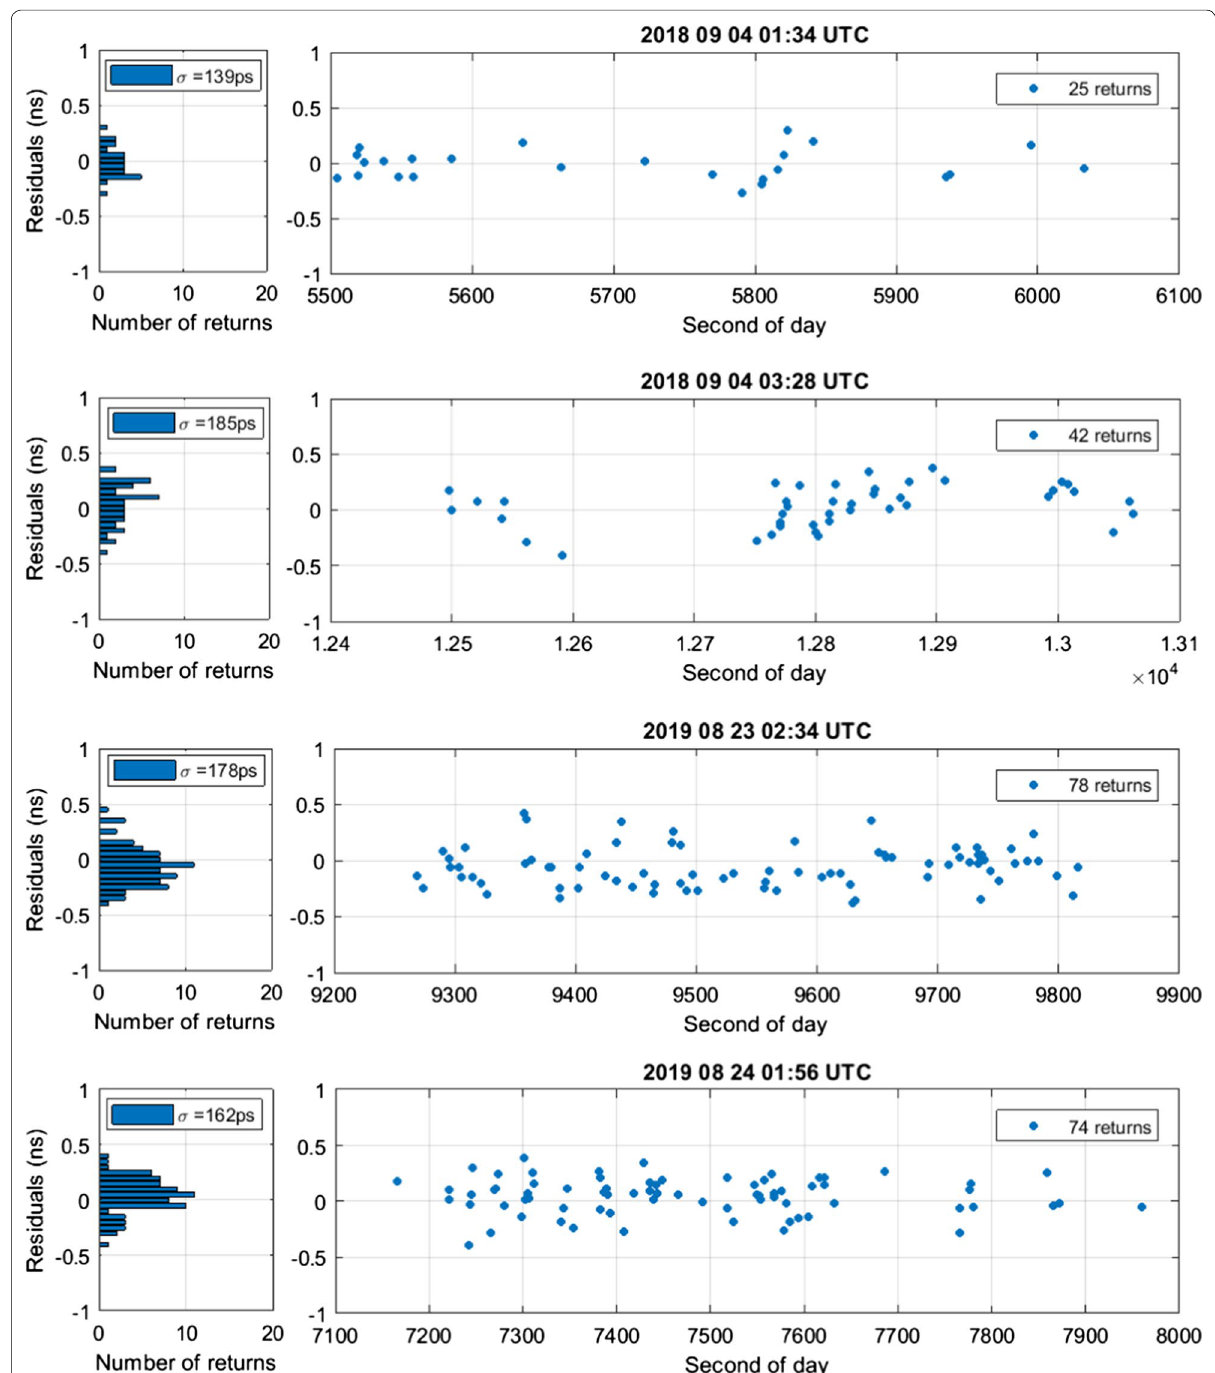
Fig. 9 Time series of the detrended residuals for the four successful passes. The residuals and their RMS are computed from the time of flight difference with the reconstructed LRO trajectory prediction made by the Paris Observatory Lunar Analysis Center (POLAC) and after a polynomial detrending (degree 3) to remove the remaining prediction